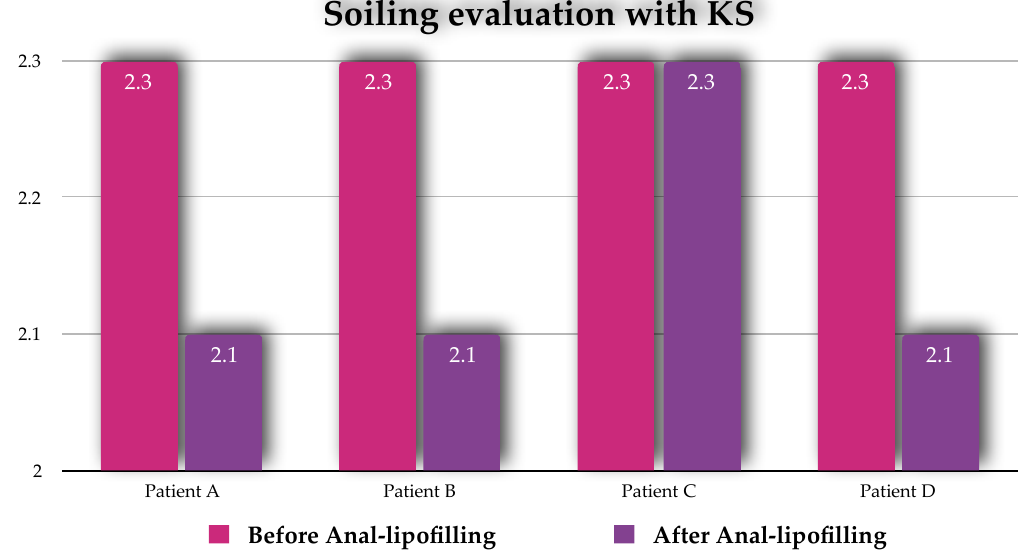
Figure 3. Results of Anal-Lipofilling on Soiling reported as Krickenbeck scale (KS) score. One patient (25%) did not benefit from the anal-lipofilling, no changes on the KS recorded before and after the procedure (Figure 3).